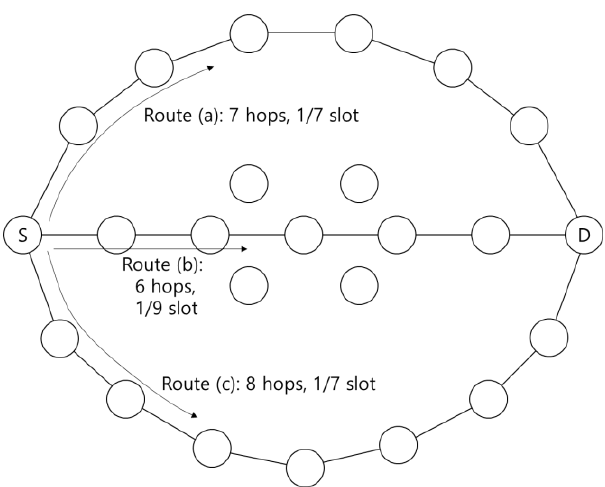
Figure 2. (Problem definition) comparison to the slot length and hop